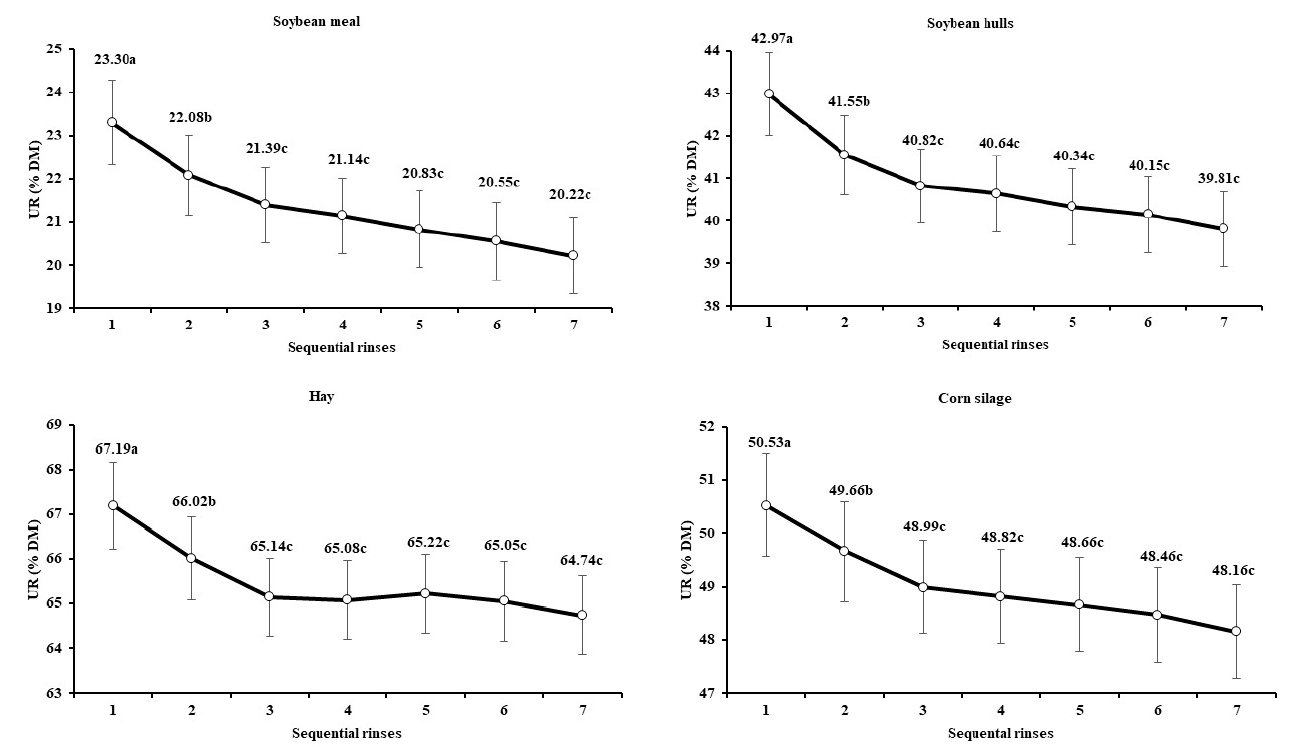
Figure 2. Least square means ( ± standard errors) for the apparently undigested residue (UR, % dry matter) in the different feeds and according to the number of rinses after in vitro incubation (means followed by different letters differ from sequential values at p < 0.05).